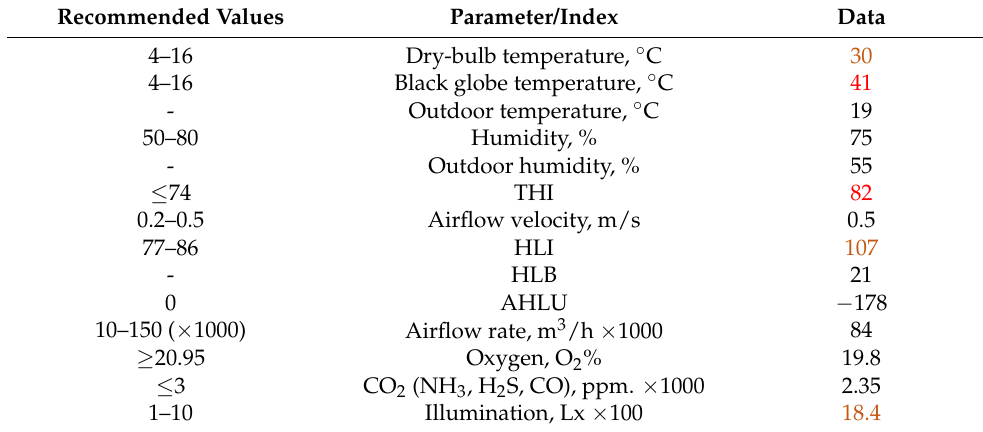
Table 5. Microclimatic conditions and indices at